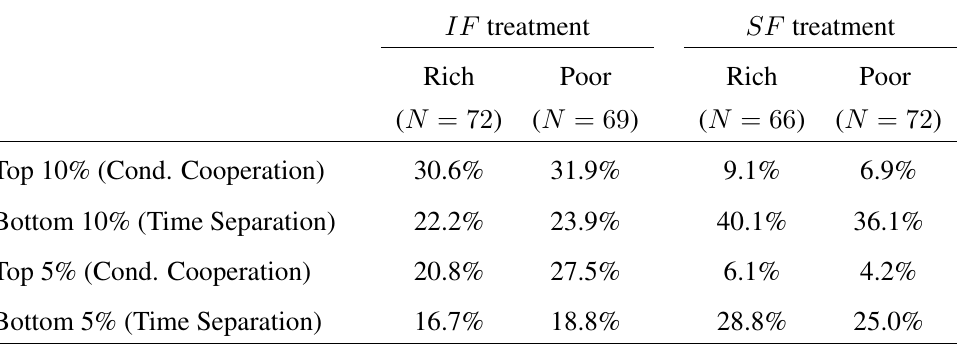
Table 4 . Relative frequencies of cycle lengths lying at the extremes of the corresponding randomly generated